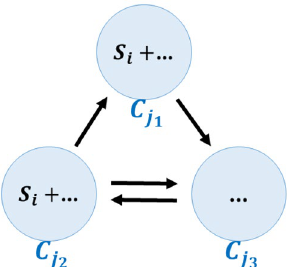
Figure 2. The topology contributing to the formation of a BC. A small linkage class of a network comprising three complexes is shown. The species S i is assumed to be present in complexes C j 1 and C j 2 , but nowhere else in the